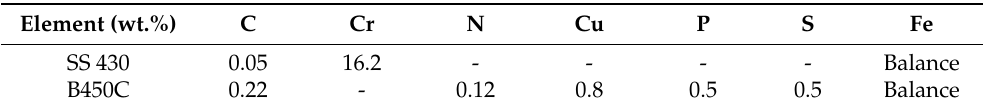
Table 1. Compositions (wt.%) of SS 430 ferritic steel and B450C carbon steel, according to suppliers Outokumpu (Finland) and Pittini Group (Italy).